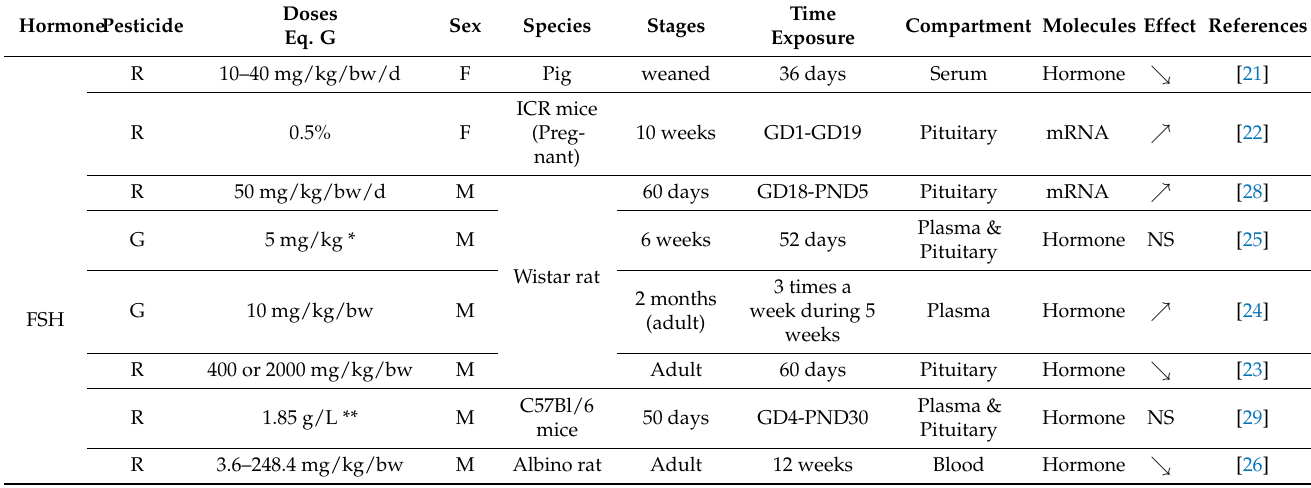
Table 1. Summary of studies on the impact of G or GBH exposure on the pituitary F: female; M: male; Eq: equivalent. Numbering in brackets indicates